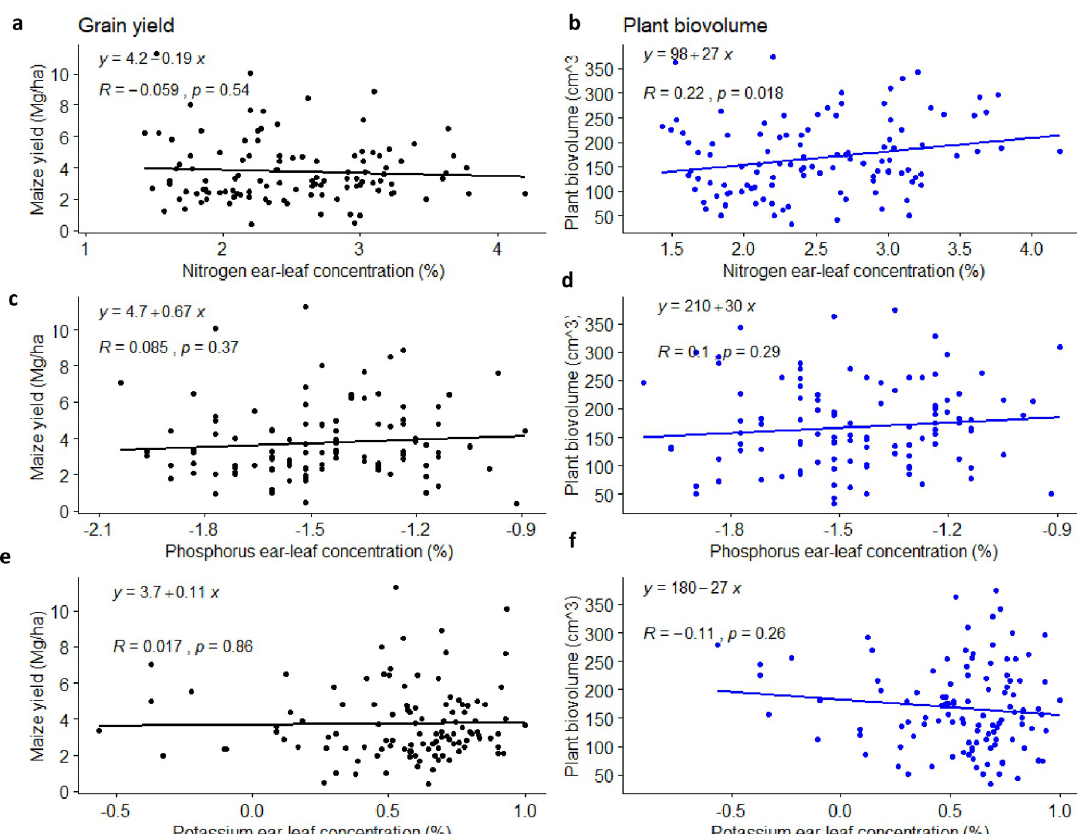
Fig 5. Relationship between grain yield (Mg ha -1 ) and plant biomass (cm 3 ) as function of maize tissue total nutrient concentration for; a, b) nitrogen (%), c, b) phosphorus (%), and e, f) potassium